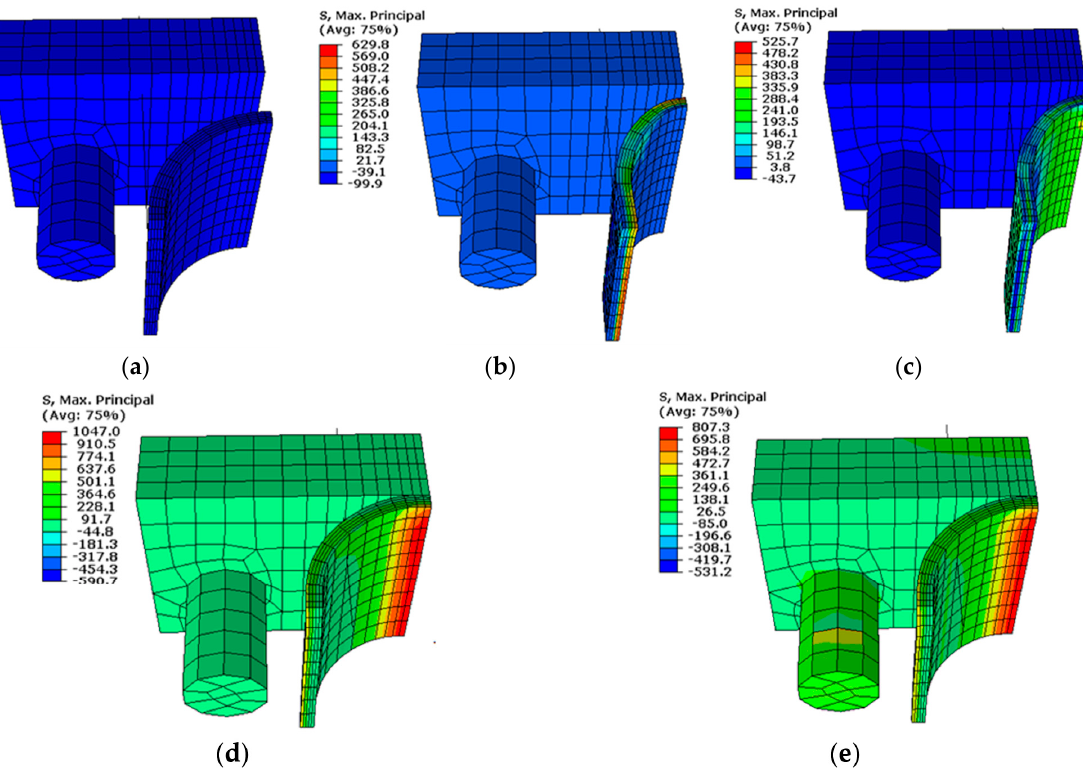
Figure 4. FEM simulation step. ( a ) Initial; ( b ) 1st deform; ( c ) Release; ( d ) 2nd deform; ( e ) Heat up to